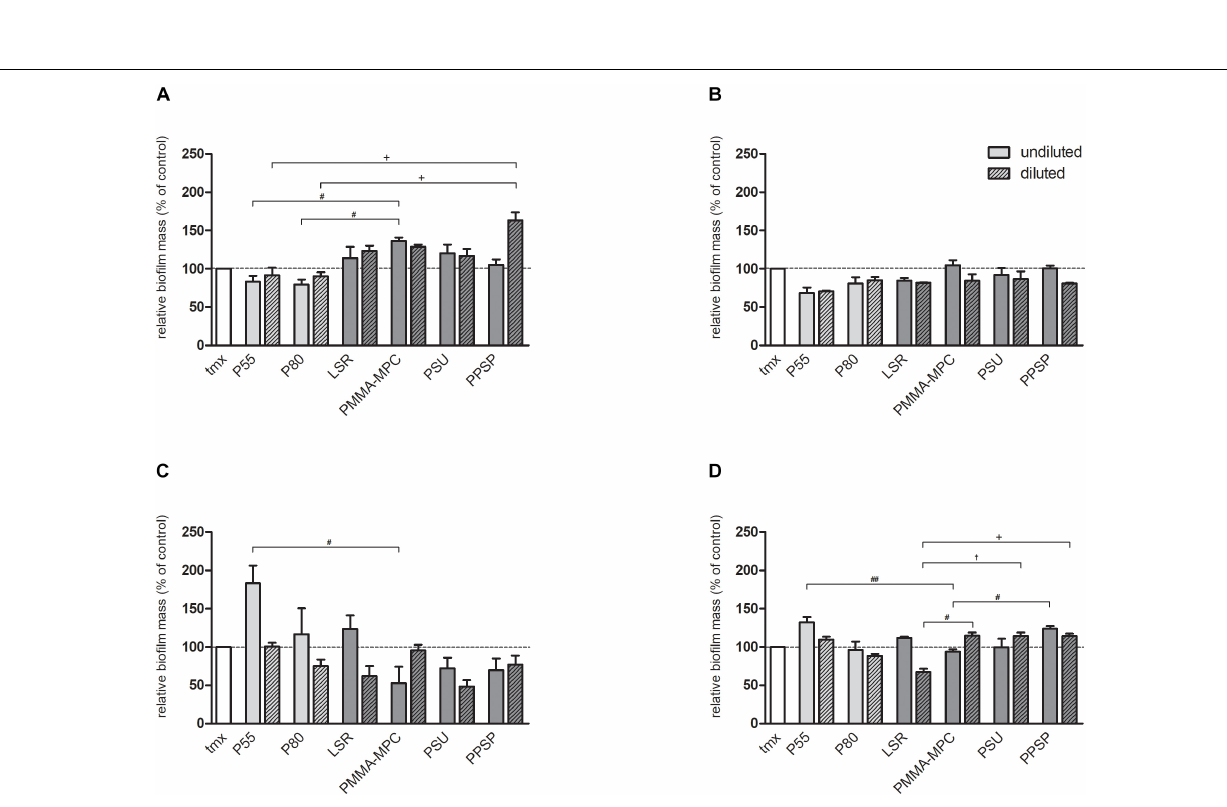
Frontiers in Bioengineering and Biotechnology |